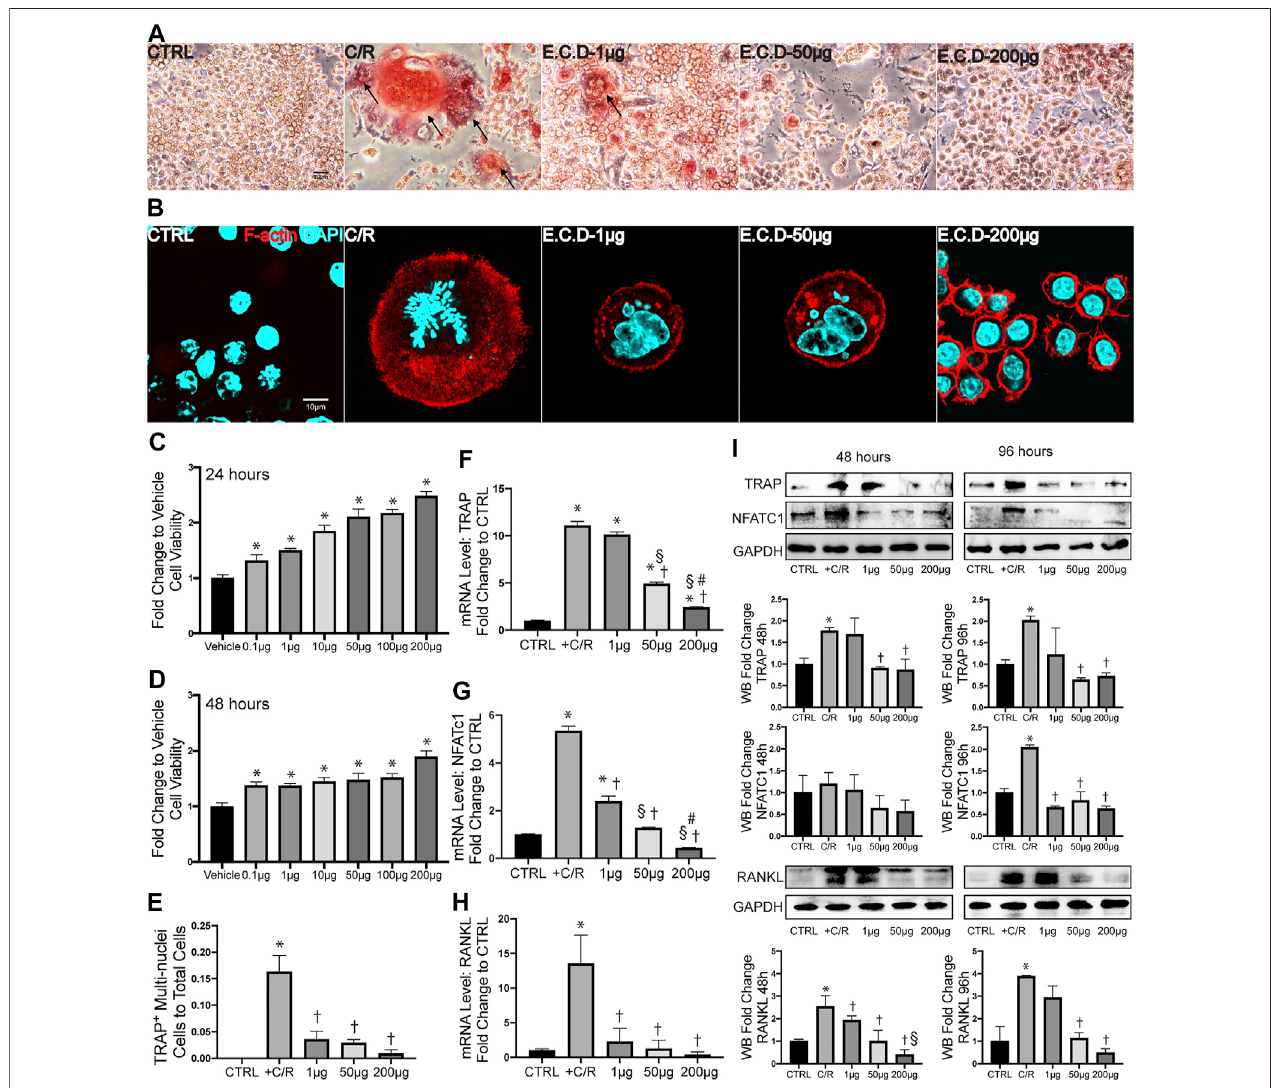
FIGURE 4 | E.C.D. extracts inhibited osteoclast differentiation in vitro . (A) TRAP staining assay displayed TRAP positive cells in Raw264.7 cells at Day 5 after C/R stimulation. The black arrow points to a mature osteoclast. The scale bar is labeled as 20 μ m. (E) The quantitative percentage of mature osteoclasts in total cells was assessed, n = 3 in each group. (B) F-actin staining was assessed at Day 5 after C/R induction. F-actin was stained ared color and DAPI was blue. The bright actin ring was formed in the C/R group, E.C.D.-L, and E.C.D.-M group. The scale bar is labeled as 10 μ m. (C,D) To assess the toxicity of E.C.D. extracts to cells, we performed CCK8 assay in vitro . The Raw264.7 cells were seeded in 96-well plate (Vehicle group, fi rst column from left) and the E.C.D. extracts in different doses were added (second column to seventh column from left). The CCK8 assay was measured 24 and 48 h later. n = 5 in each group. Data were analyzed as mean ± SEM, * vs. Vehiclegroup, p < 0.05. (F – H) ThemRNAexpression levelofTRAP,NFATc1,andRANKLweremeasured 48 hafterC/Rstimulation, n =3ineachgroup. (I) Theprotein levelofTRAP,NFATc1,andRANKLwereassessedat48and96 hafterC/Rstimulation.Theimmunoblottingwasshownintheupperpanelandquantityofdensitometric valuesfold change wasshown in the lowerpanel. n = 3in each group. Datawere analyzed as mean± SEM, * vs. CTRL group, † vs. + C/R group, § vs. 1 μ ggroup, #vs. 50 μ g group, p < 0.05.